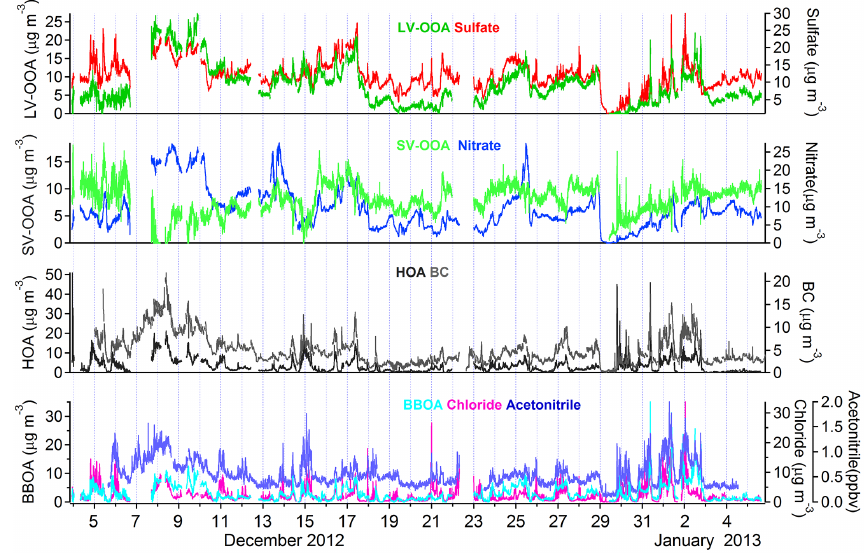
Figure 6. Time series of OA fractions and external tracers (sulfate, nitrate, BC, chloride and